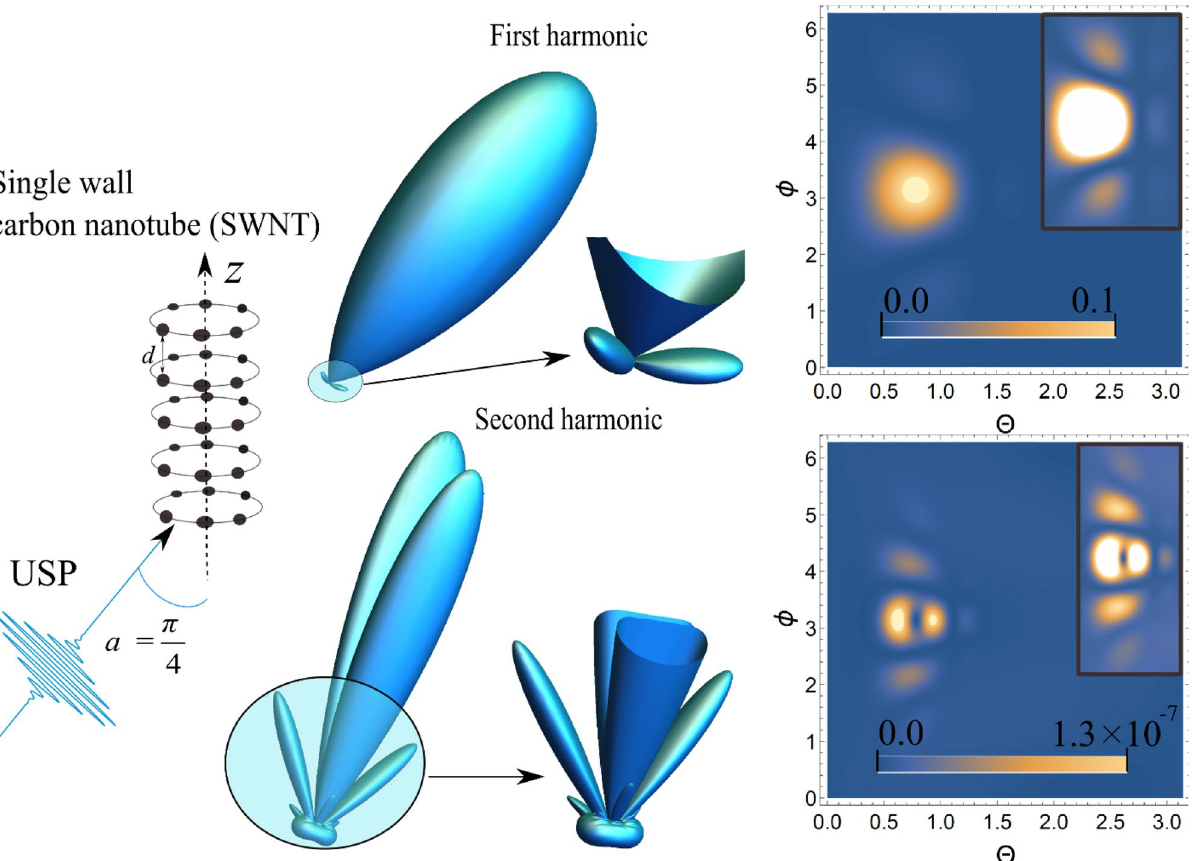
Figure 3. 3D radiation pattern of the scattering spectra USP [see Eq. (1)] and the contour plot for the spectra, where θ and φ are angles (in radians) with a spherical coordinate system, i.e. polar and azimuth angles, respectively. Inserts in contour plots show an enlarged (more contrasting) scatter spectrum. The first harmonic is in the figures above, and the second harmonic is below. A USP was selected with a frequency ω 0 =100 au, a pulse duration γ corresponding to 43 as. and amplitude E 0 = 1000 au. The number of planes L = 8 , the distance between planes d = 2 au, and the ring radius R = 4 au. The angle of incidence α between n 0 and the z axis was selected as α = π/ 4